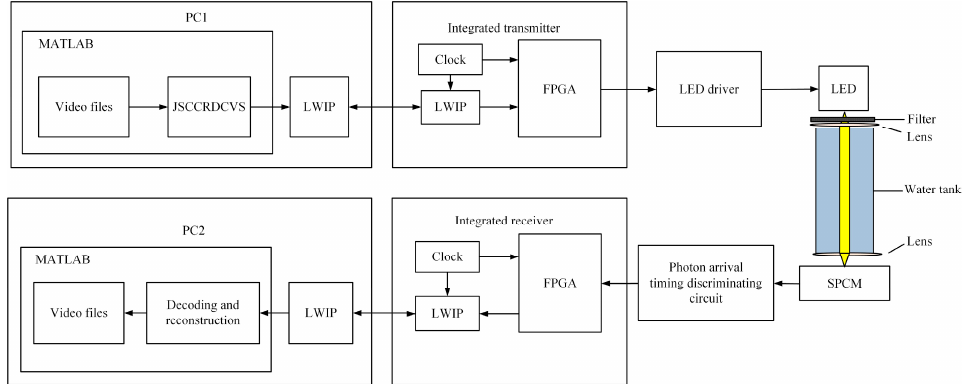
Figure 3. The structure diagram of system. LED, led lamp; SPCM, single photon counter module; FPGA, field programmable gate array; JSCCRDCVS, joint source and channel coding scheme based on residual distributed compressive video sensing; LWIP, a lightweight TCP/IP stack; PC, personal